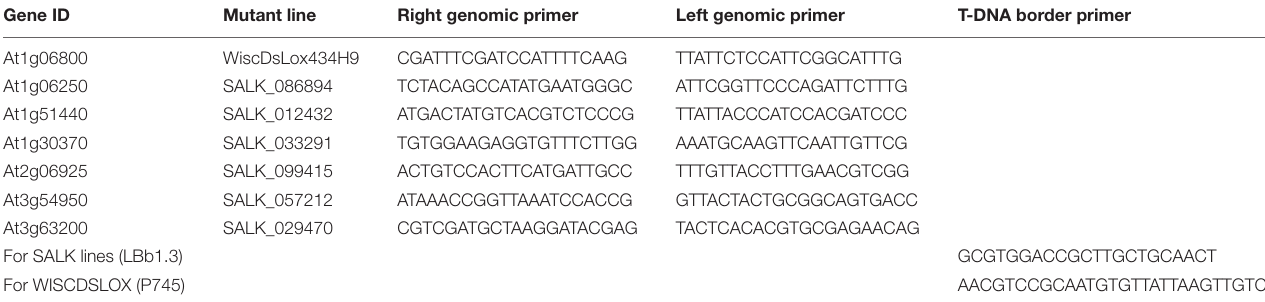
TABLE 2 | Primers used for T-DNA homozygous mutant lines identification. Gene ID Mutant